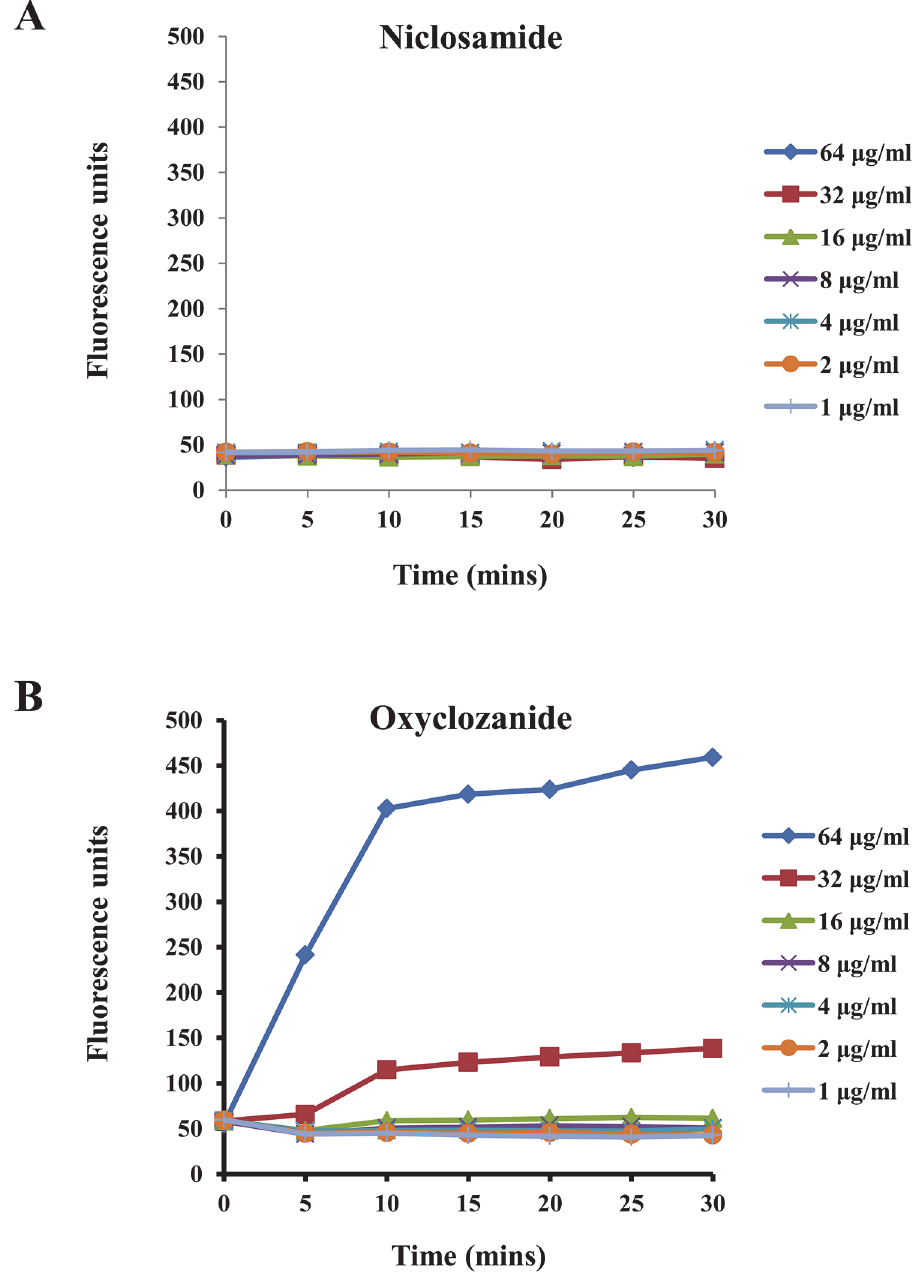
Fig 5. Permeabilization of MRSA cells by niclosamide and oxyclozanide. Time course of membrane permeabilization by oxyclozanide (A) and niclosamide (B) was measured by following the increase in Sytox Green fluorescence ( λ exc = 485 nm; λ em = 530 nm). The drugs were tested at serially diluted concentrations between 1 to 64 μ g/ml.